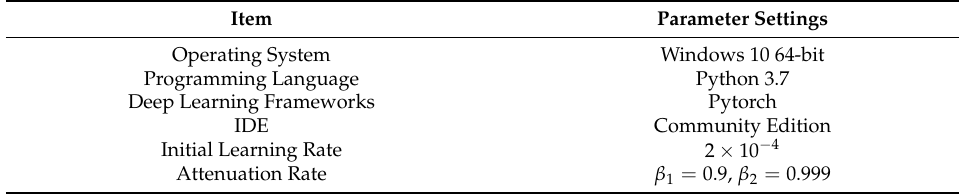
Table 3. Software environment.